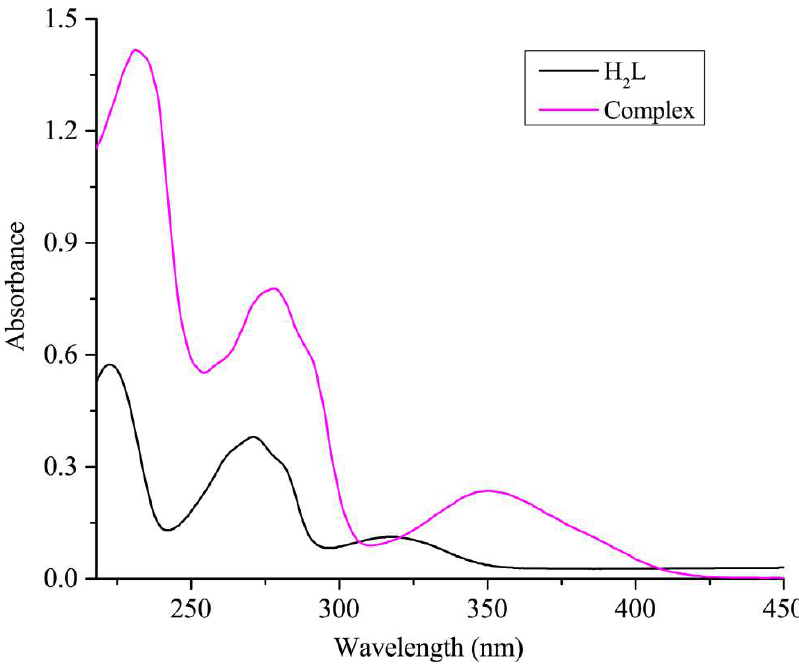
Figure 1. The UV–Vis spectra of H 2 L and its Zn II –Eu III complex (cm −1 ).